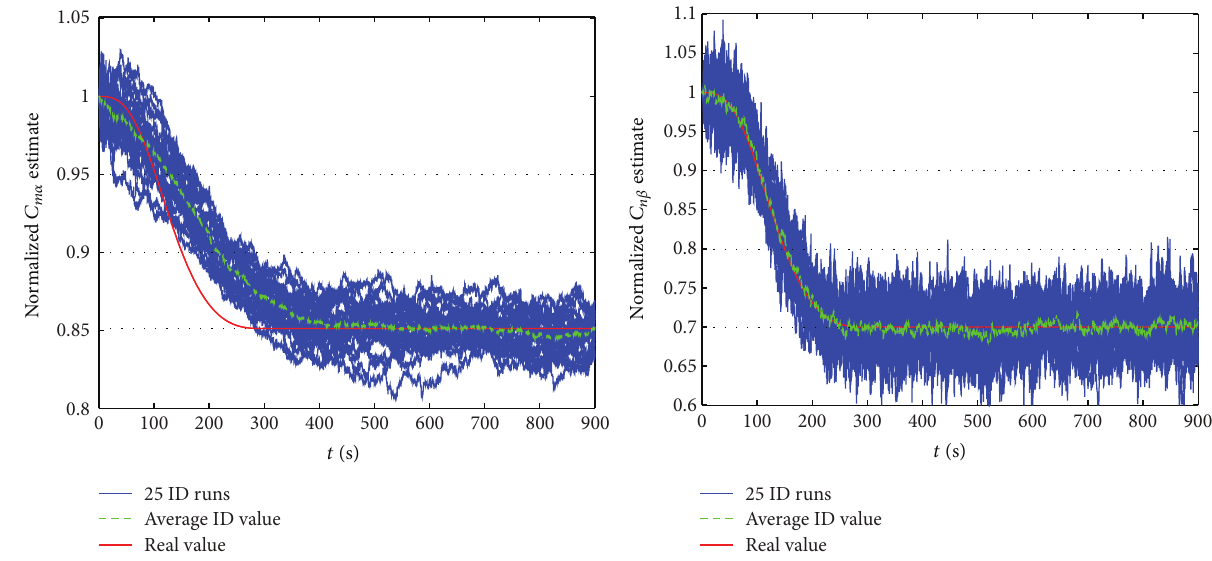
Figure 5: ID results for severe/rapid icing